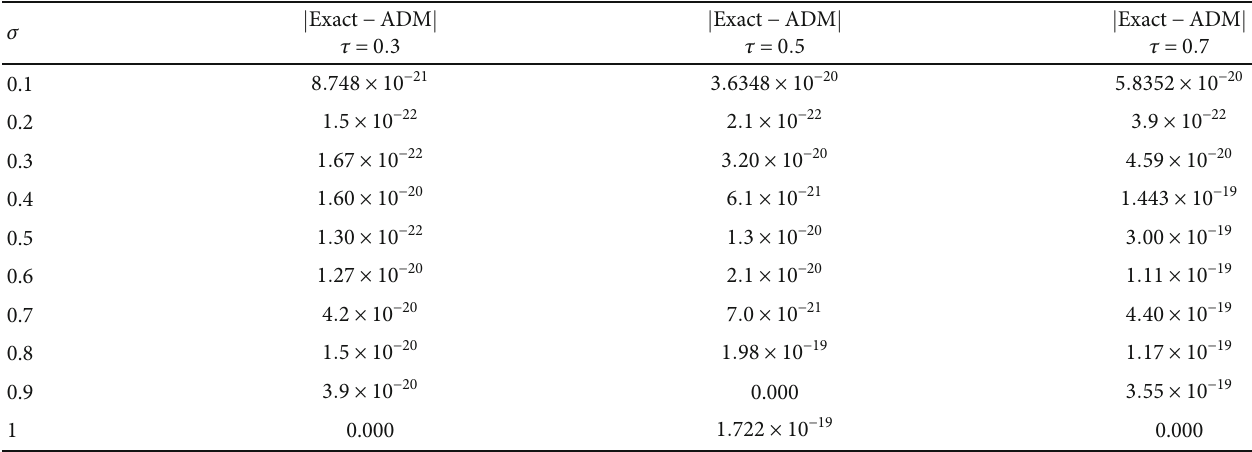
Table 2: Absolute error of Example 5.2 at δ = 1/2